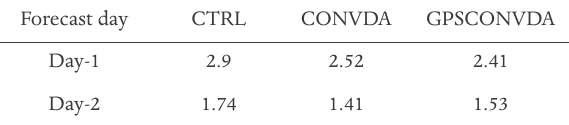
Forecast day CTRL